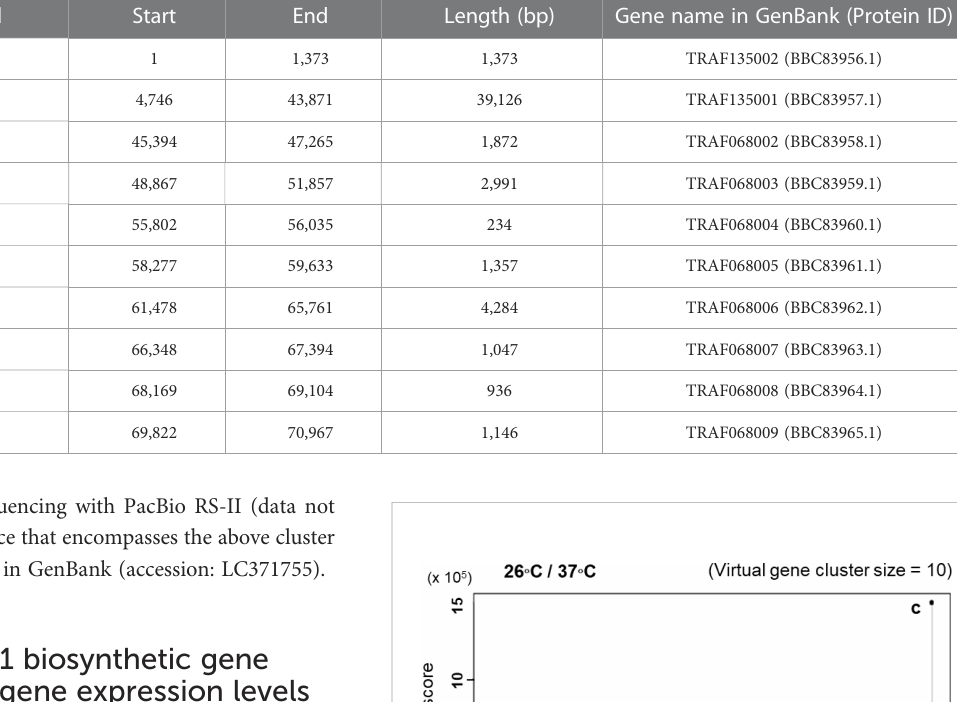
TABLE 2 Genetic locus information in the KK-1 cluster.